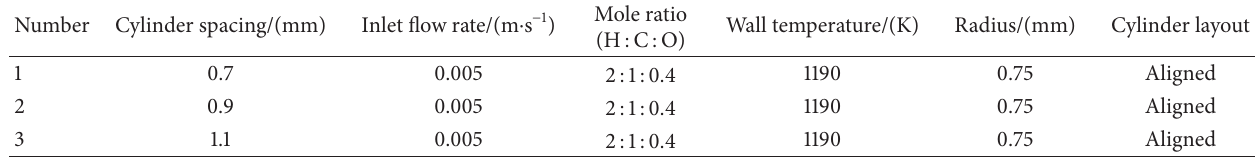
Table 5: Operating parameters with different cylinder